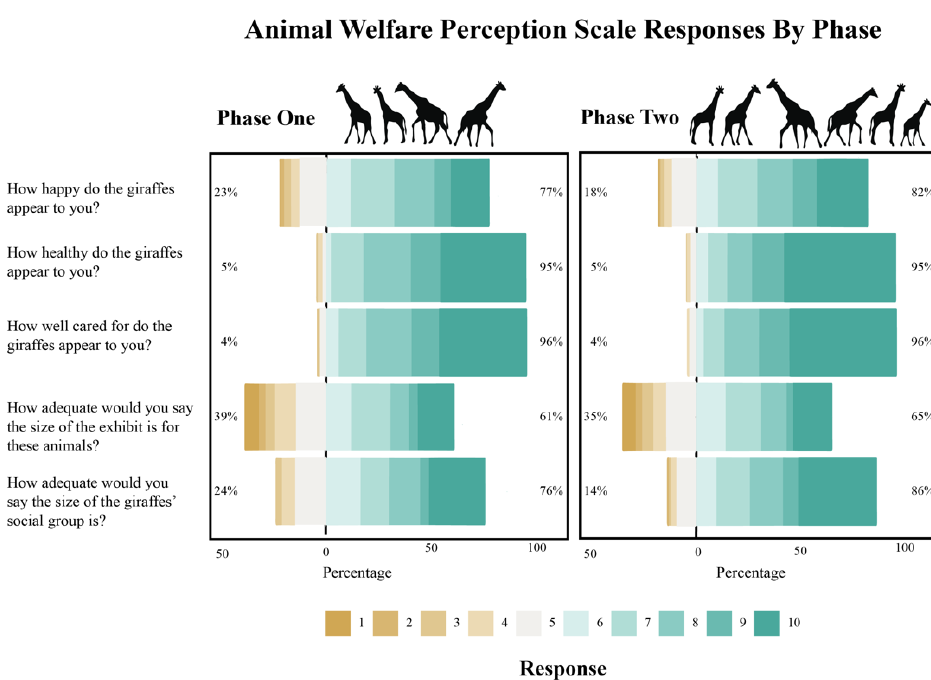
Figure 1. Animal welfare perception scale response by phase.